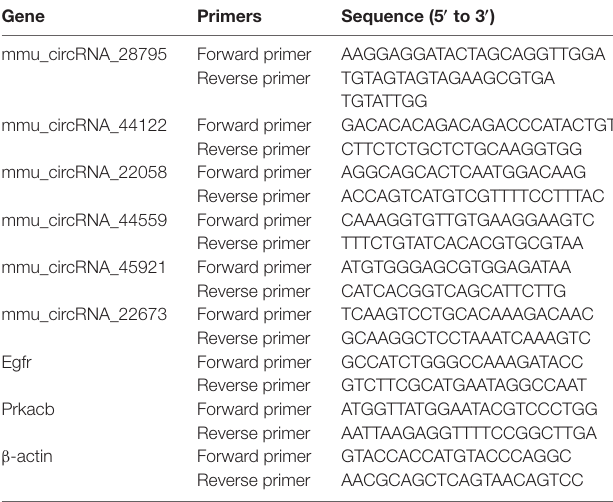
TABLE 1 | The forward and reverse primers for qPCR. Gene Primers Sequence (5 (cid:48) to 3 (cid:48)